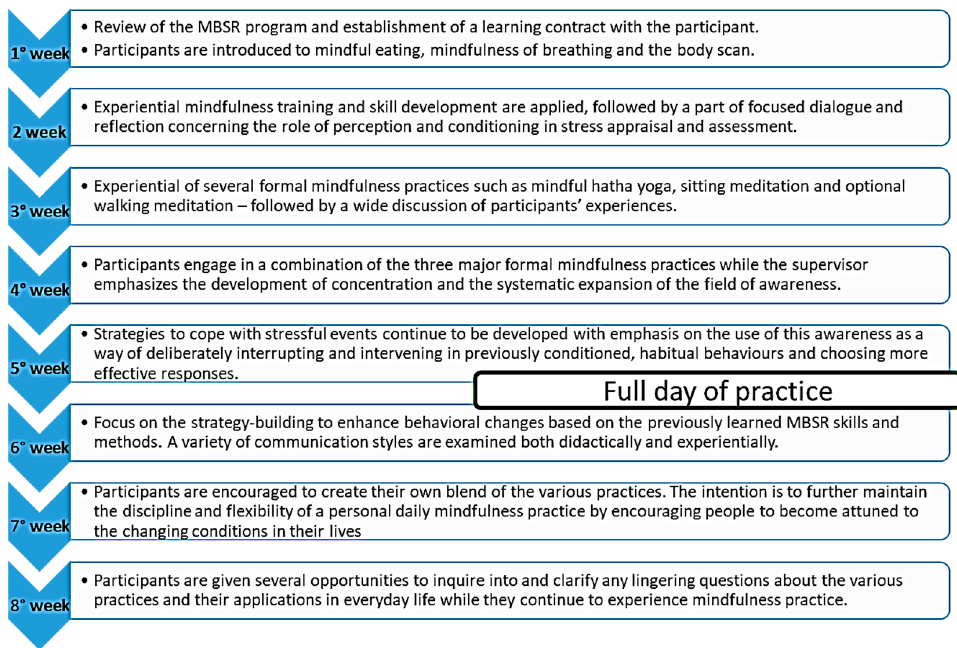
Figure 1. Activities performed during the sessions of the MBSR program.